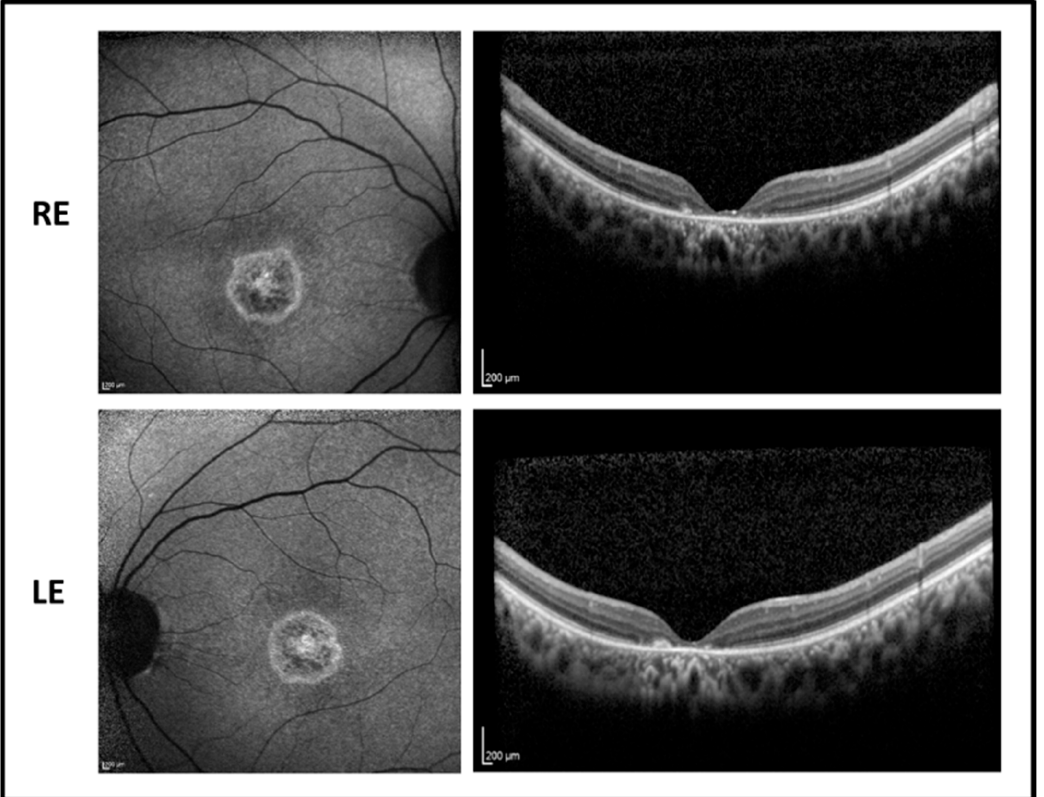
Figure 1. Fundus autofluorescence ( left side ) and optical coherence tomography (OCT) ( right side ) images of the right eye (RE) and left eye (LE) of patient 1 showing macular hyperfluorescence and foveal atrophy with backscattering phenomenon.